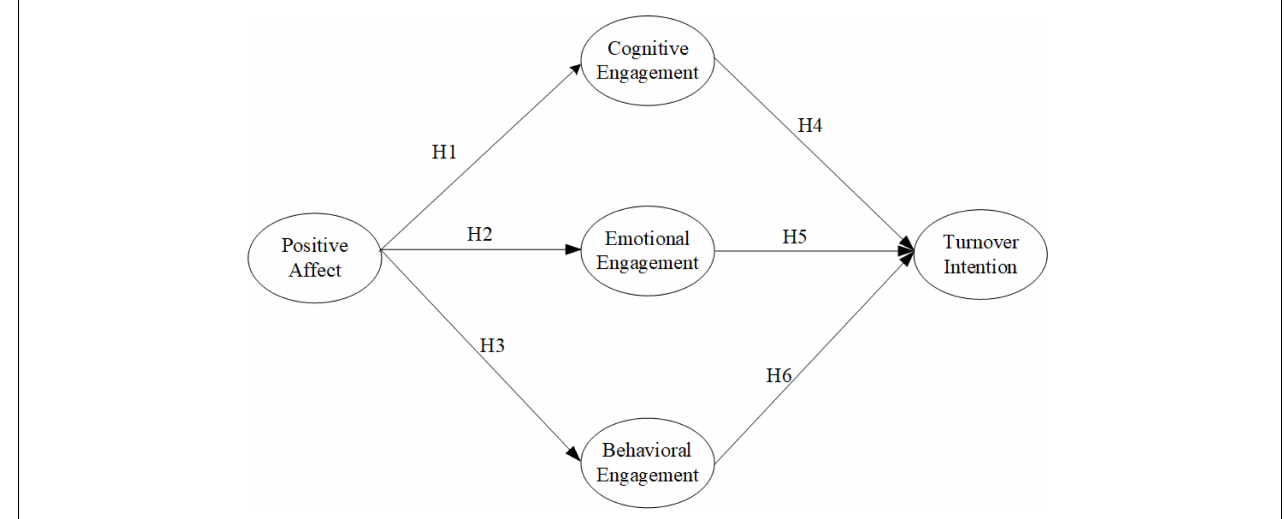
FIGURE 1 | The hypothesized research